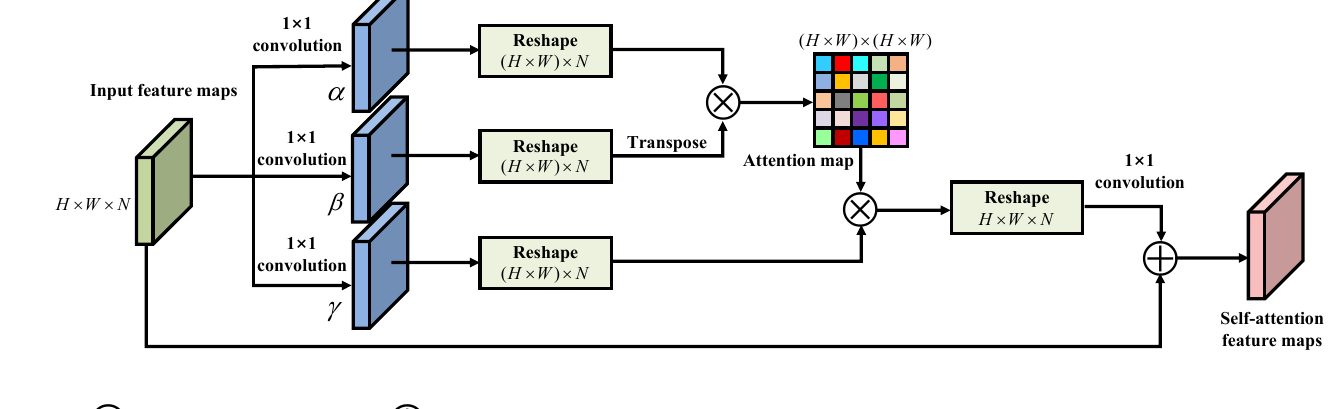
Figure 2. Illustration of the self-attention